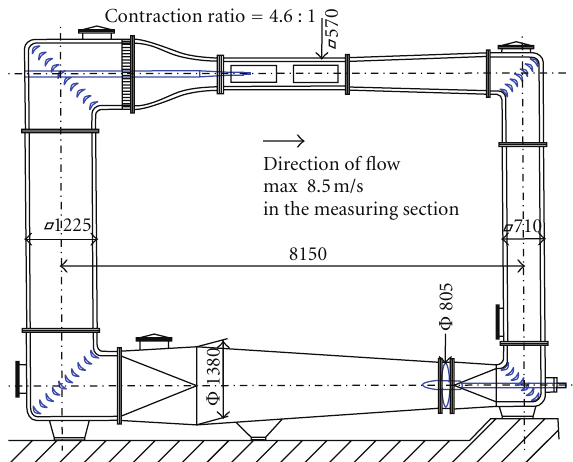
Figure 1: Main dimension of DINAEL cavitation tunnel.